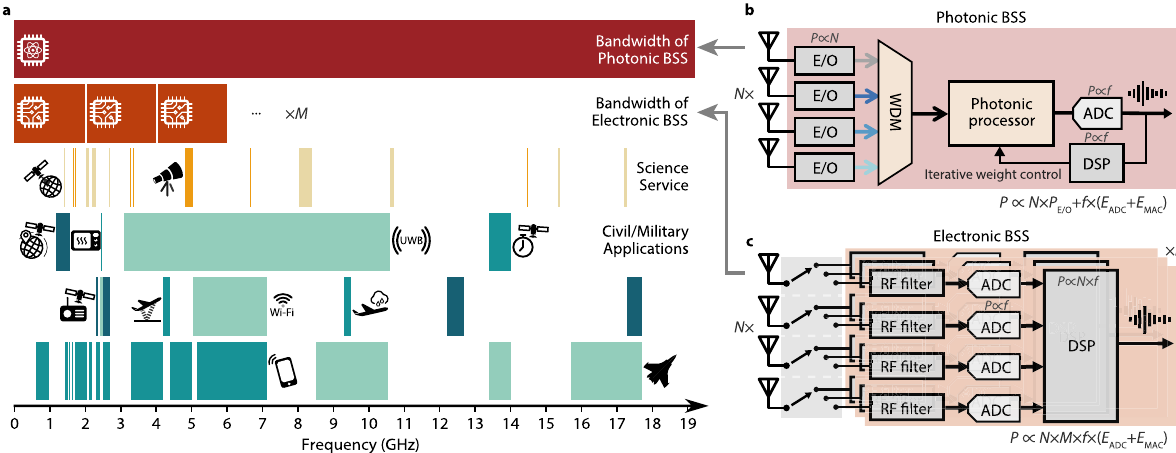
Fig. 1 | Architecture comparison between electronic and photonic BSS imple- mentation. a Frequency allocation for common bands (from 0.5 to 19GHz) and example processing bandwidths for the two BSS implementations (photonics and electronics). Science service bands comprise the earth explorer satellite service (EESS)and radio astronomy service (RAS).Bands for civil and military applications include global positioning system (GPS), microwave oven, ultra-wideband (UWB), and standard frequency and time signal service (for the fi rst row); broadcasting- satellite service, radar altimeter, Wi-Fi, and aircraft weather radar (for the second row); 5G cellular networks and military radar (for the third row). b Photonic BSS system diagram. c Electronic BSS system diagram. In electronic BSS, covering the